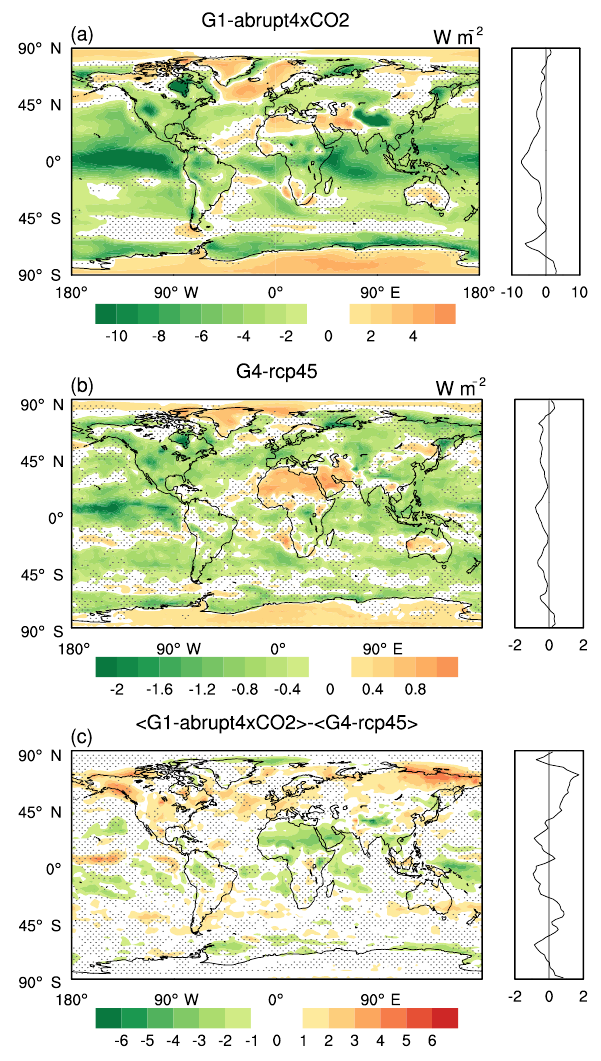
Figure 1. Geographical distributions over the 40-year analysis periods of differences in net radiation flux at TOA between G1 − abrupt4 × CO2 (a) and G4 − rcp45 (b) . Panel (c) shows the differences in net radiation flux at TOA between normalized G1 − abrupt4 × CO2 and G4 − rcp45. Stippling indicates regions where fewer than five of six models agree on the sign of the model response. The right-hand sub-panels show the zonal average of the left-hand sub-panels. Note that all three panels have different colour